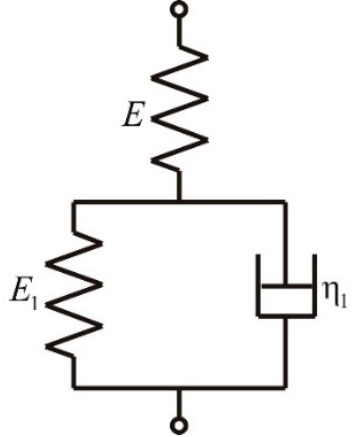
Figure 6. Schematic diagram of the standard model with the component properties in symbolic des- ignation.